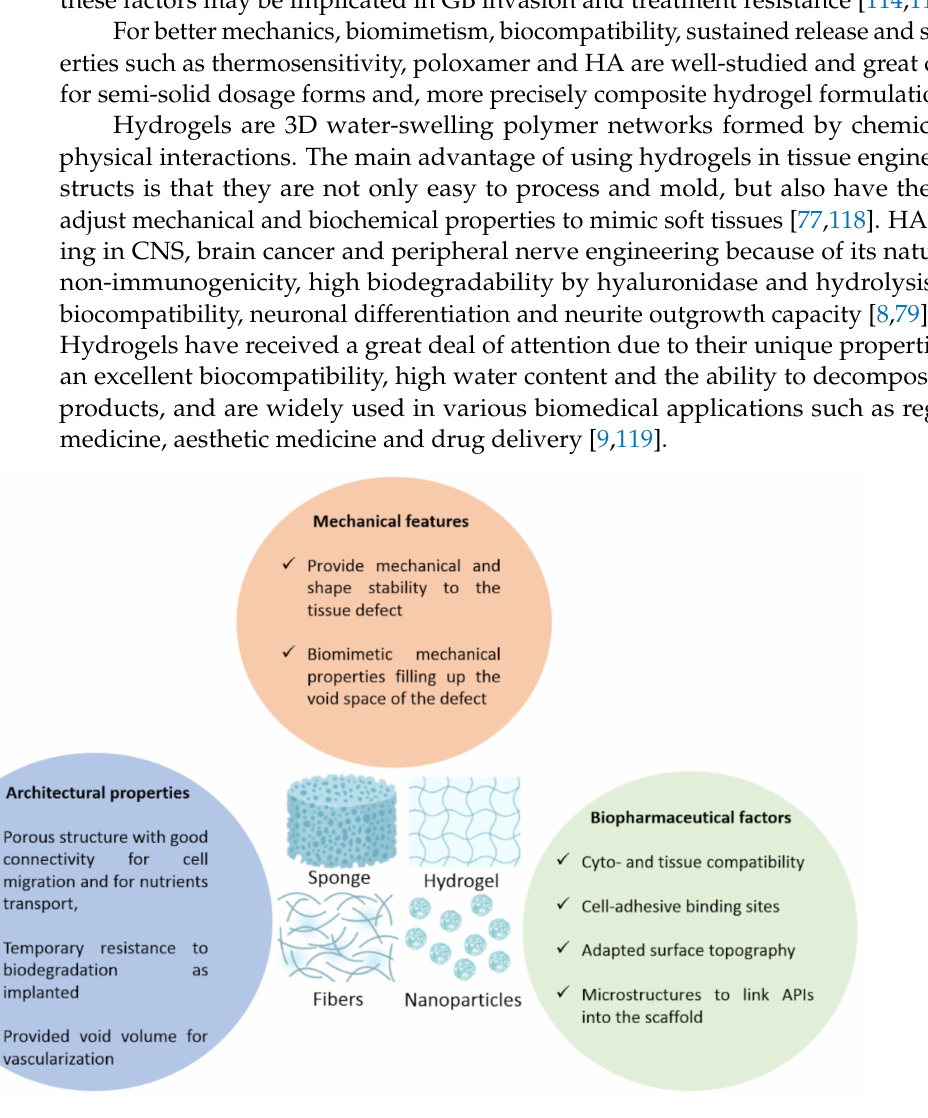
Figure 4. Scaffold specifications depending on various parameters. The specifications that are usually expected in scaffolds whether it is sponges, hydrogels, fibers or nanoparticles, that closely mimic the brain’s ones like shape stability and close biomechanical features. Moreover, architectural properties that are usually linked to porosity, connectivity and a transient stability upon degradation. Finally, biopharmaceutical factors like cyto and tissue compatibility, binding sites, microstructure of the